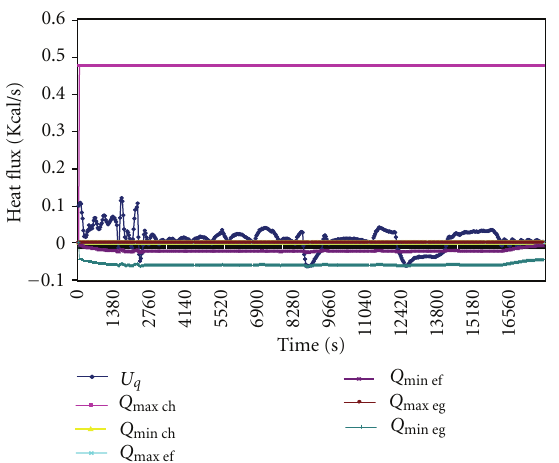
Figure 13: Evolution of temperature ( T cons ), the adjusted set-point ( T cdoc ) and reaction mixture ( T r ), K = 0.5, K r =